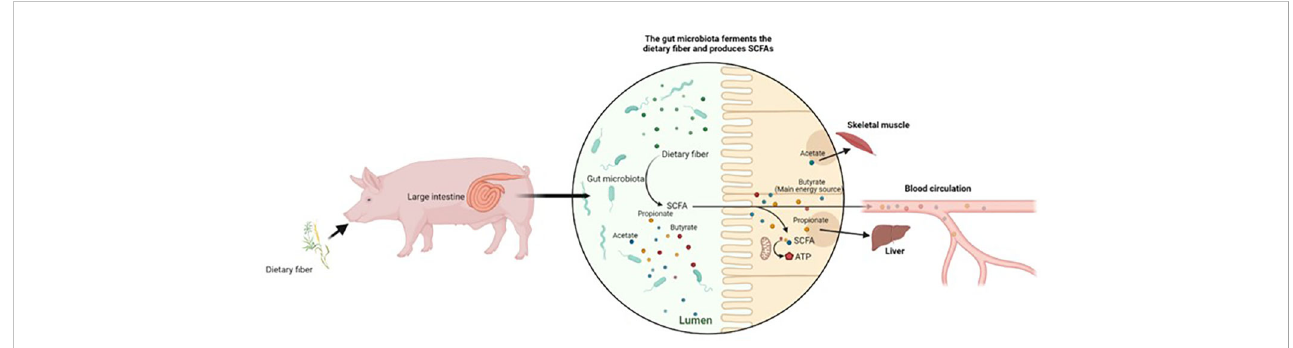
FIGURE 1 Microbial fermentation process and SCFA